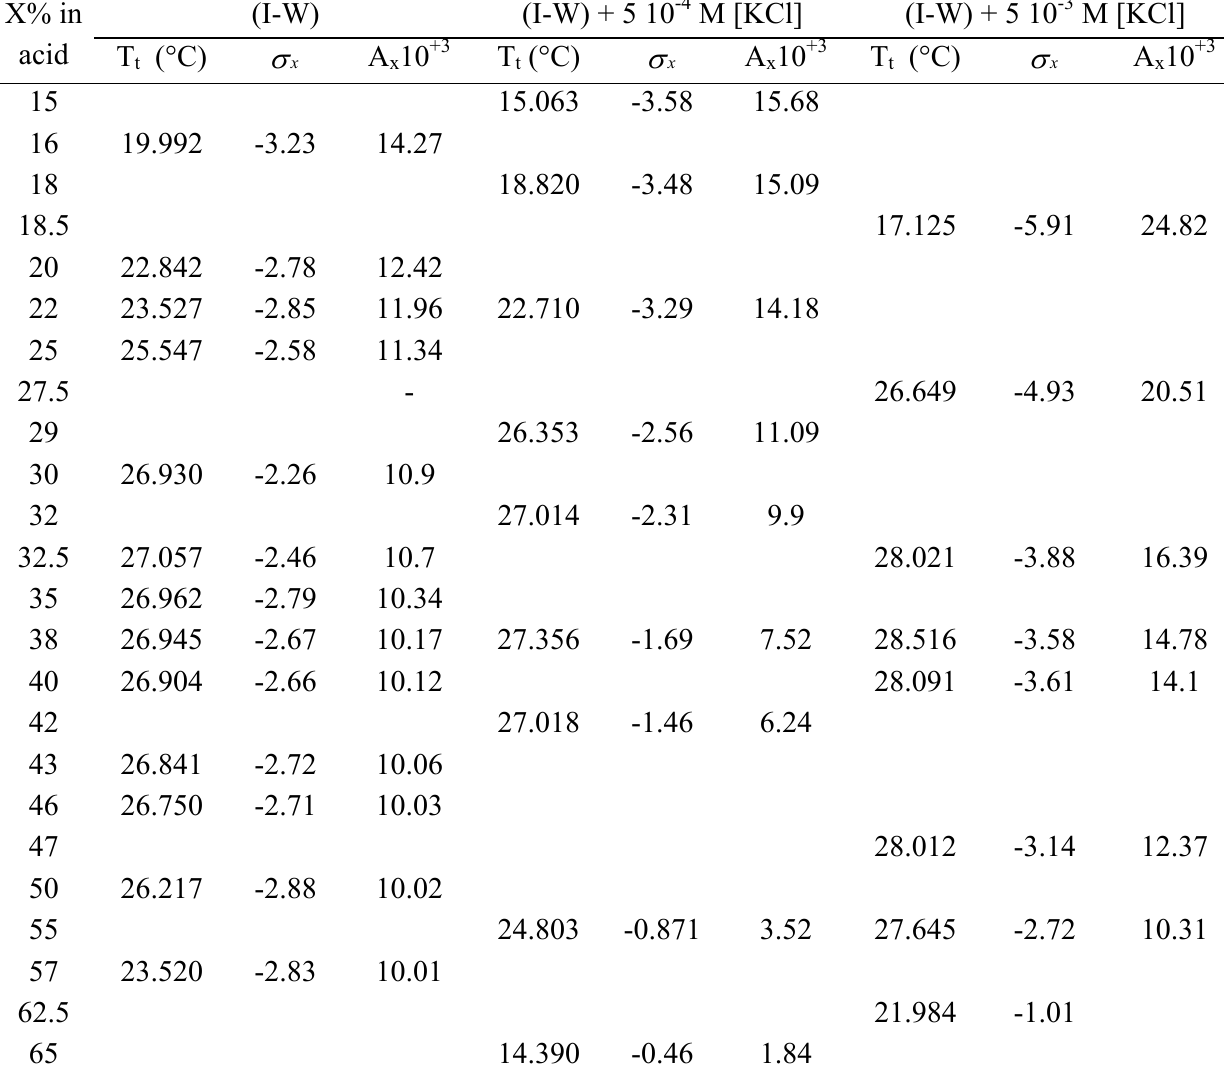
Table 1. Results of fitting of data from figure 1 using relation (6). The parameter values of A are expressed in Ω -1 cm -1 K -1 and Ω -1 cm -1 respectively. T each composition X % in isobutyric